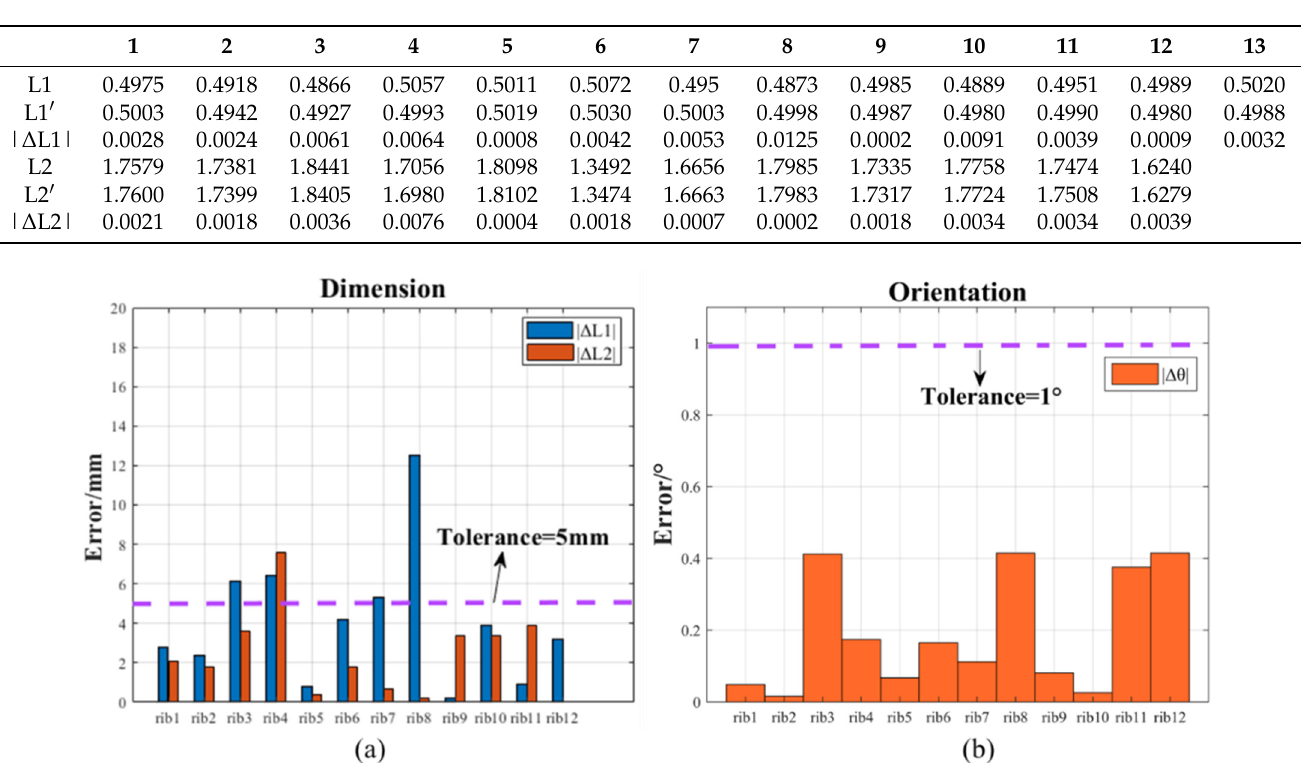
Table 3. Dimension and location assessment results for prefabricated T ribs compared with manually measured results (measurement unit: m).